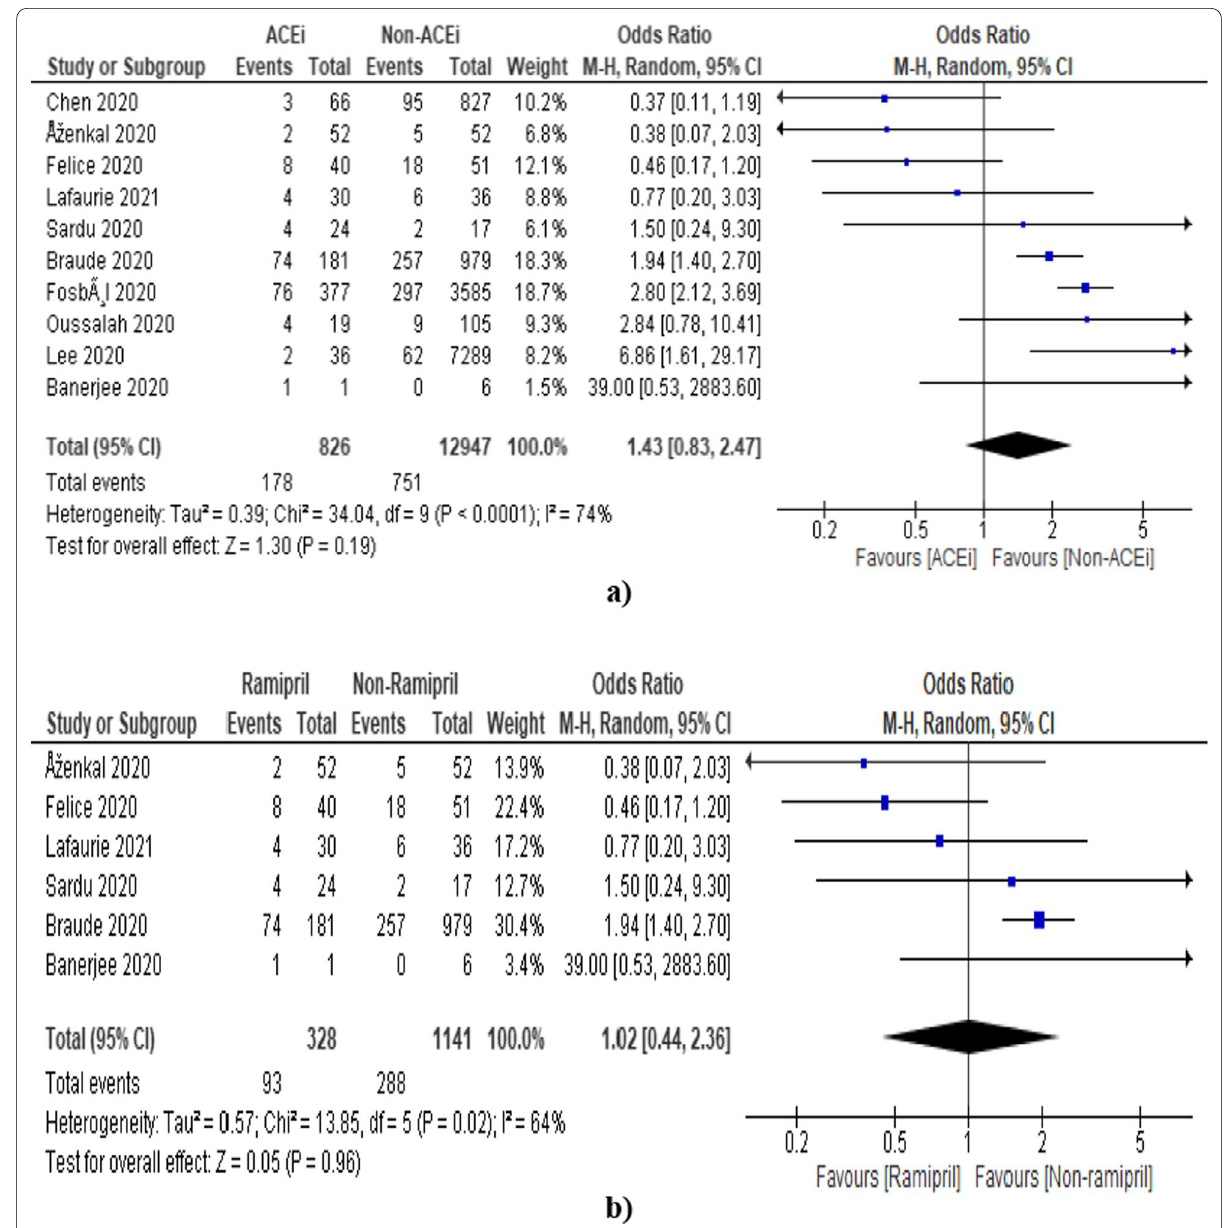
Fig. 4 Forest plot showing overall estimate in terms of odds ratio using random effect model a ACEi b